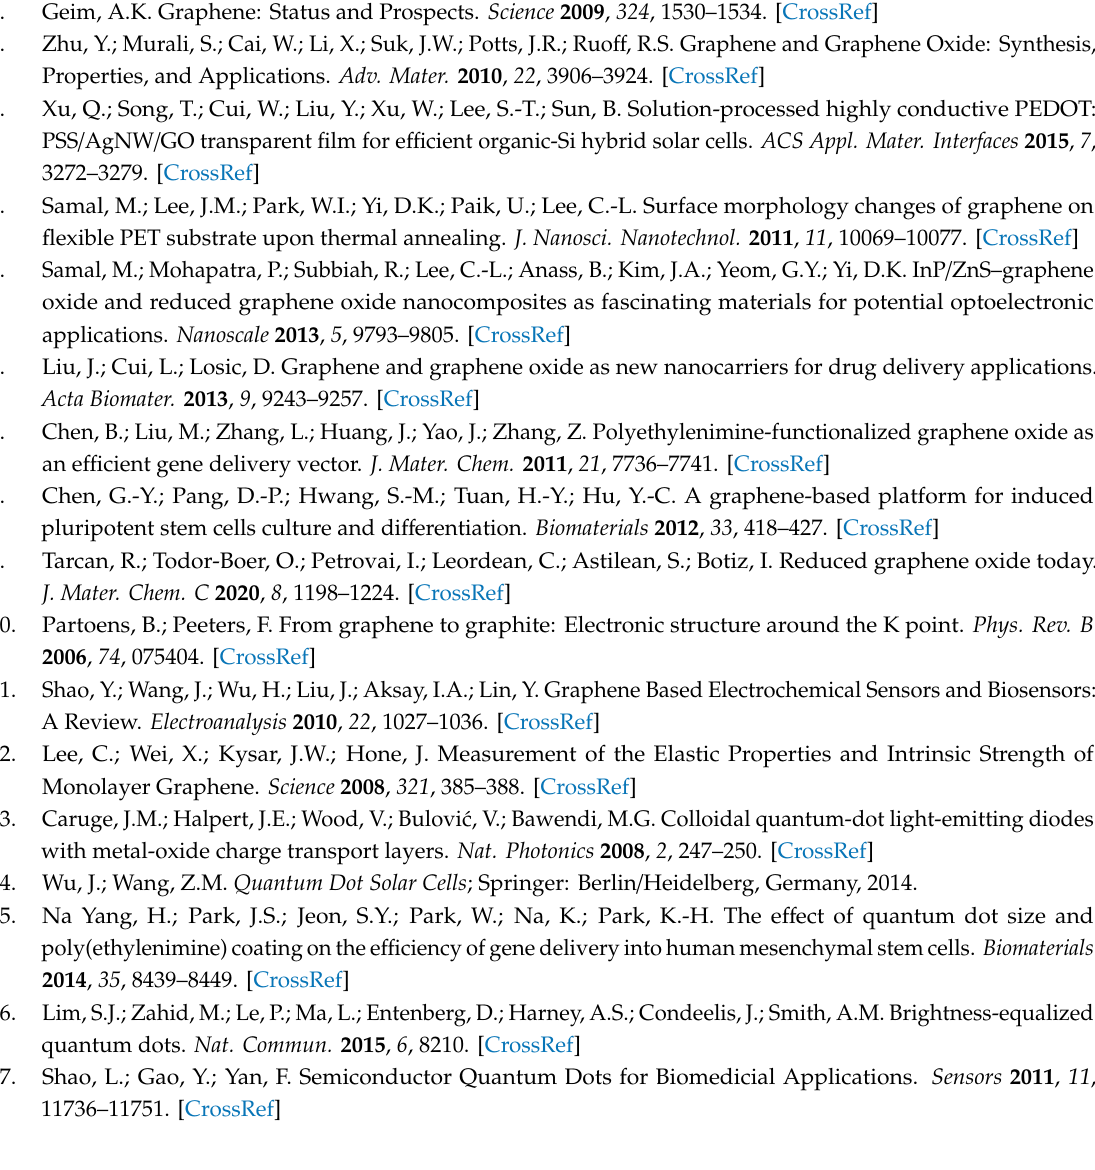
Supplementary Materials: The following are available online at http: // www.mdpi.com / 2079-4991 / 10 / 12 / 2550 / s1, 1: Full scan XPS spectrum of ( A ) GQPs and ( B ) GQDs, Figure S2: SEM image of cells after treatment of GQDs and GQPs, Figure S3: Bio-imaging of GQDs and GQPs in HeLa. Fluorescence emission of both GQDs increased with increasing incubation time, Figure S4: 3D reconstructed confocal images for analysis of cellular distribution of GQDs and GQPs in HeLa. The fluorescence emission was present in whole cell. The two images at the bottom of figure were the 3D reconstructed confocal images of blocking endocytosis at low temperature, Table S1: The relative contents of various elements of GQDs and GQPs in full scan XPS spectrum, Table S2: The relative contents of various bonds of GQDs and GQPs in C1s XPS spectrum, Table S3: Detail value of cellular response (Avg: average, Std: Standard